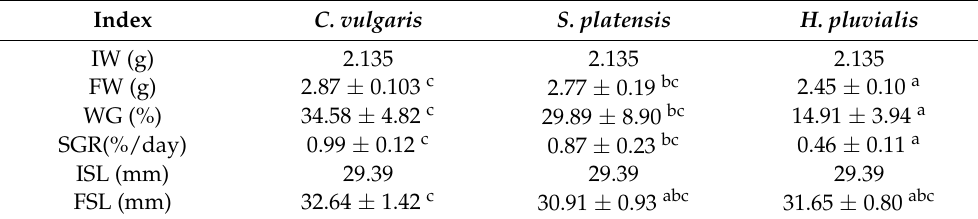
Table 4. Effects of microalgae biomass on growth performance of pearl oyster ( Pinctada fucata martensii ). Index C. vulgaris